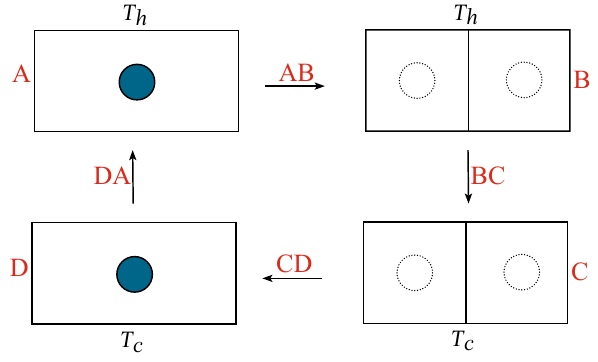
Figure 1. The four stages of the Stirling cycle. In A and D, solid circles represent the particles. Dashed circles in B and C represent the uncertainty in the position of the particle. Box A and B contacts the hot bath temperature T h , however, the boxes C and D contact the cold bath temperature T c . The stages BC and DA are isochoric processes. Stage AB is the isothermal insertion process, while stage CD is the isothermal removal